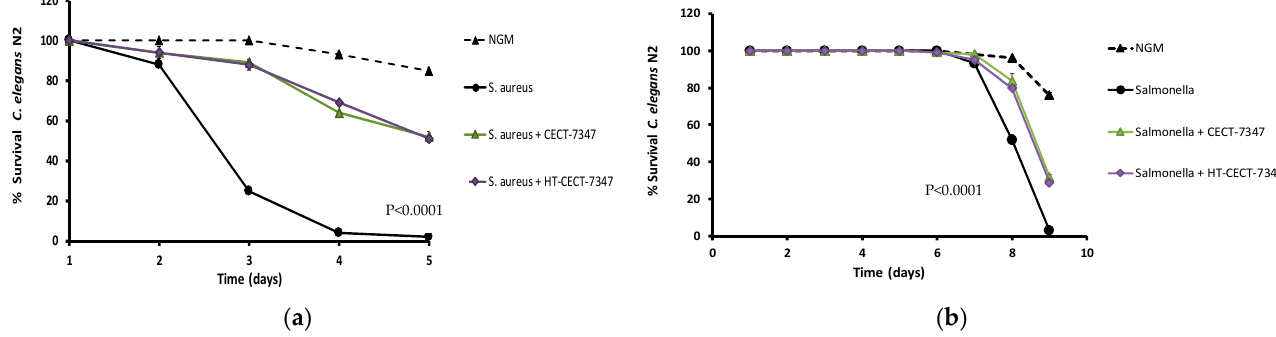
Figure 8. Effect of CECT 7347 and HT-CECT 7347 on resistance of C. elegans to S. aureus and S. enterica subsp. enterica serovar Typhimurium. ( a ) Worms fed with E. coli OP50 (control), S. aureus , and CECT 7347 or HT-CECT 7347 in the presence of the pathogen. Worms fed with B. longum cells (both live and heat-treated cells) were more resistant to infection ( p < 0.0001) ( b ) Worms fed with E. coli OP50 (control), S. enterica subsp. enterica serovar Typhimurium, and CECT-7347 or HT-CECT 7347 in the presence of the pathogen. Worms fed with B. longum cells (both live and heat-treated cells) were more resistant to infection ( p < 0.0001). Log Rank T-test was applied. Data are the average of two independent experiments ( n = 100/condition).